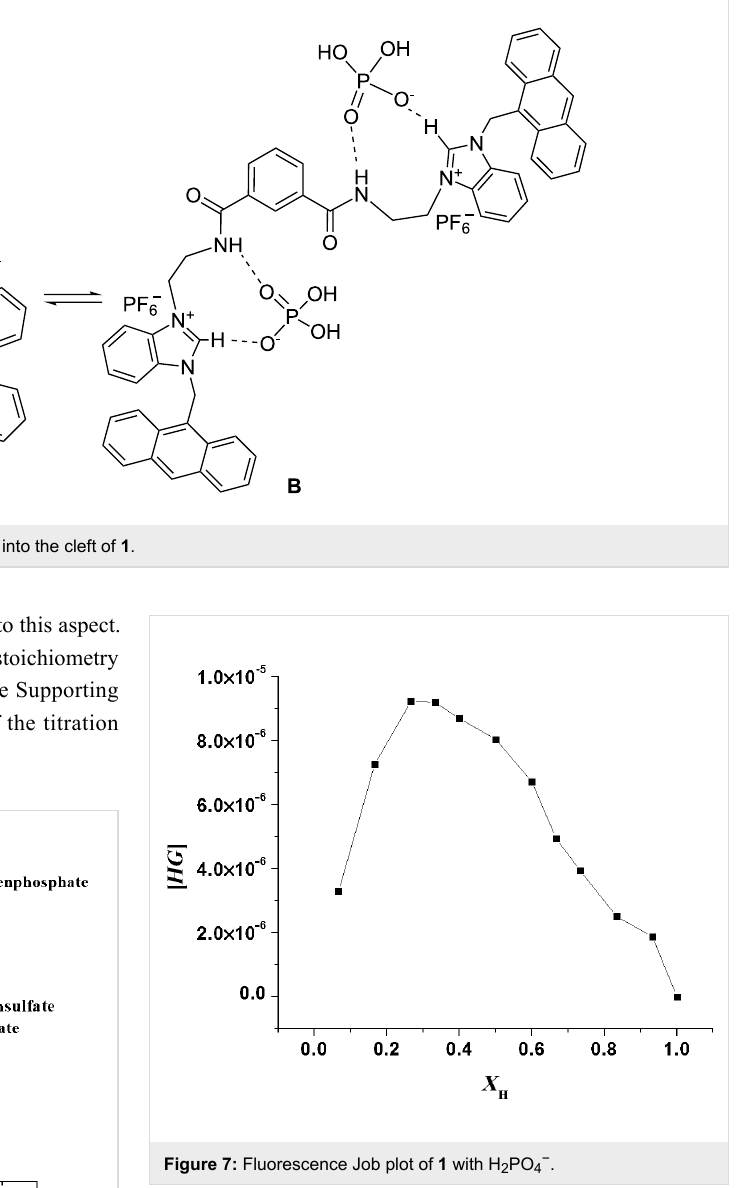
Figure 7, for example, represents the Job plot [37] for H 2 PO 4 − , which corresponds to a clear-cut case for 2:1 stoichiometry of the complex. In the binding process, cooperative interaction of the two benzimidazolium motifs in 1 are primarily necessary for a large change in emission. This was proved by considering the model compound 2 , where only one binding site is present for interaction. Under similar experimental conditions, the emis- sion of 2 was only slightly changed.